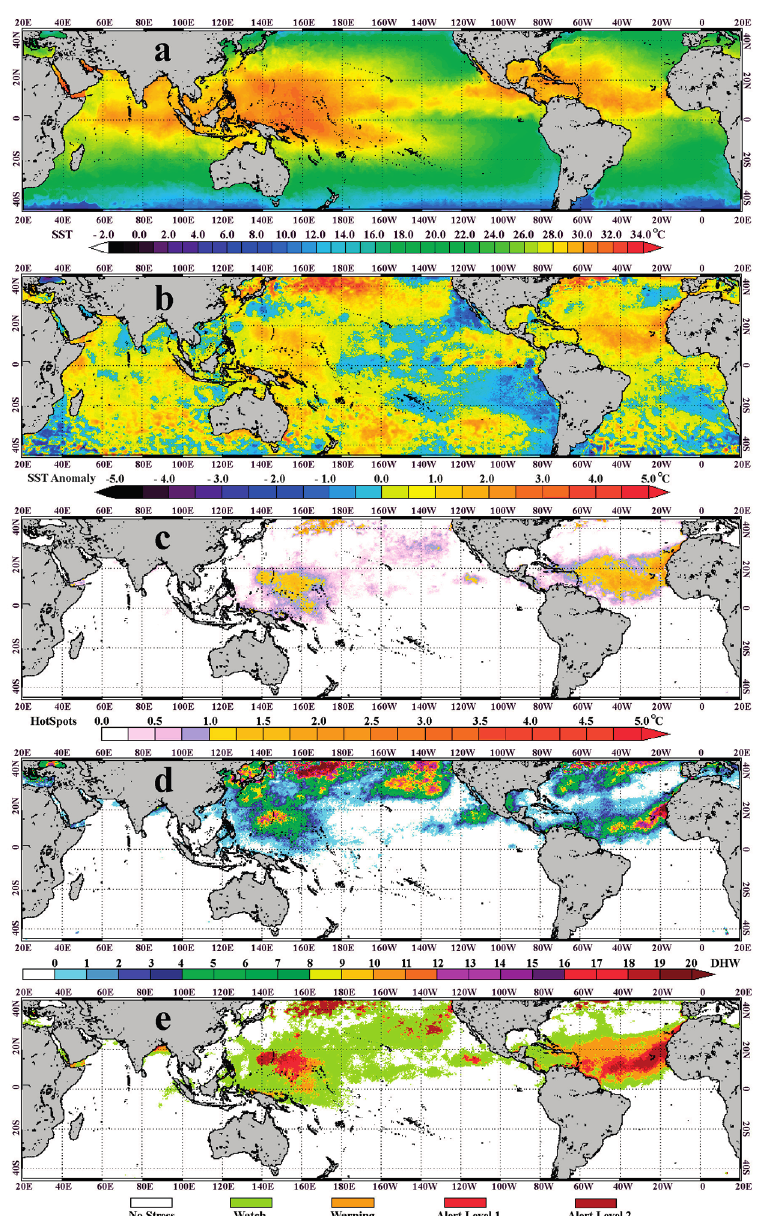
Figure 2. NOAA CRW’s daily global 5-km products for 3 October 2013: ( a ) sea surface temperature (SST); ( b ) SST Anomaly; ( c ) Coral Bleaching HotSpots; ( d ) Degree Heating Weeks; and ( e ) 7-day maximum composite Bleaching Alert Area, in which Alert Levels 1 and 2 values around Guam and the Commonwealth of the Northern Mariana Islands (CNMI) identified areas where bleaching was underway at that